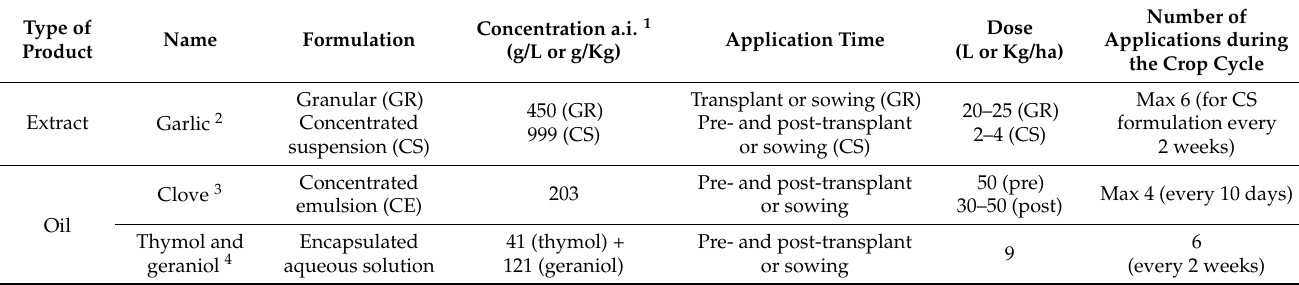
Table 4. List of plant extracts allowed for use as nematicide in Southern EU